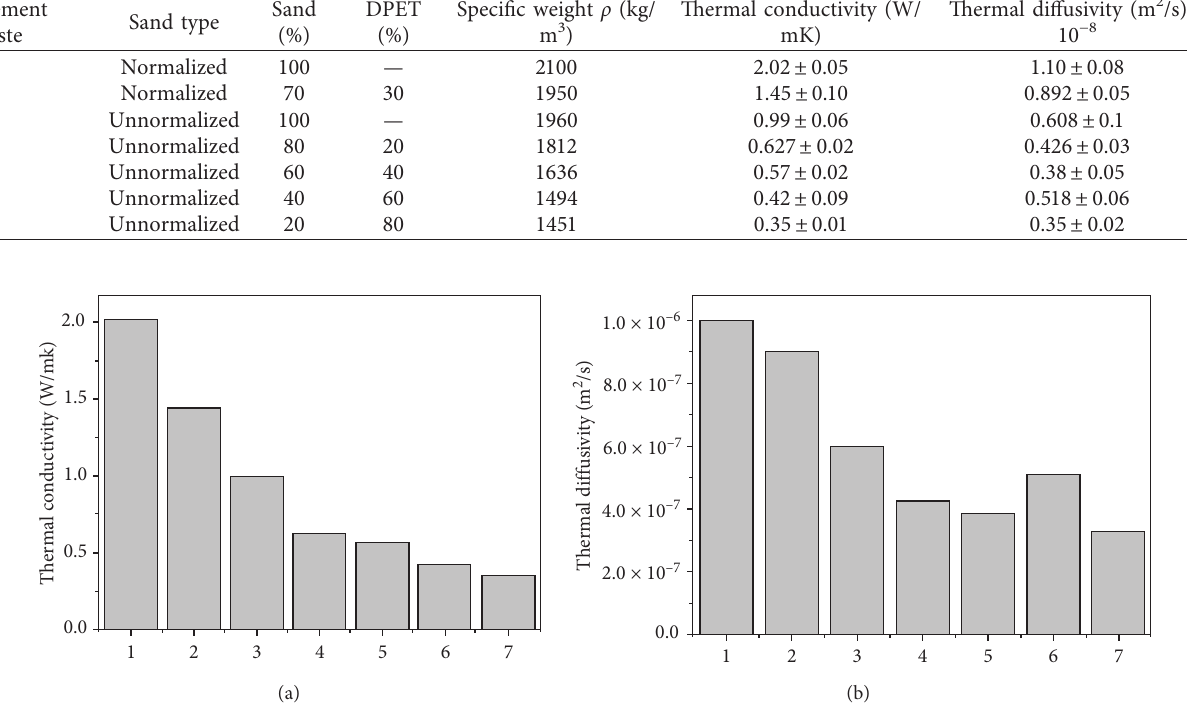
Figure 7: (a) Reduction of the thermal conductivity according to each mixture type; (b) reduction of the thermal diffusivity according to each mixture type. Table 4: Results of flexural and compressive strength of cementitious pastes with different weight additions of DPET. Cement paste